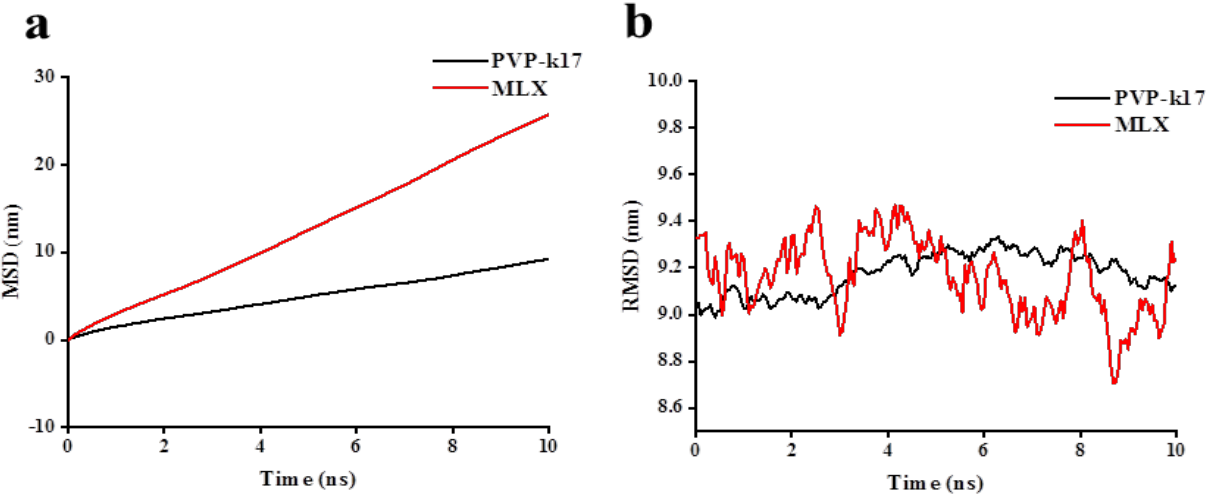
Figure 6. The mean square displacement ( a ) and root mean square deviation ( b ) between MLX and PVP-k17 within 10 ns.